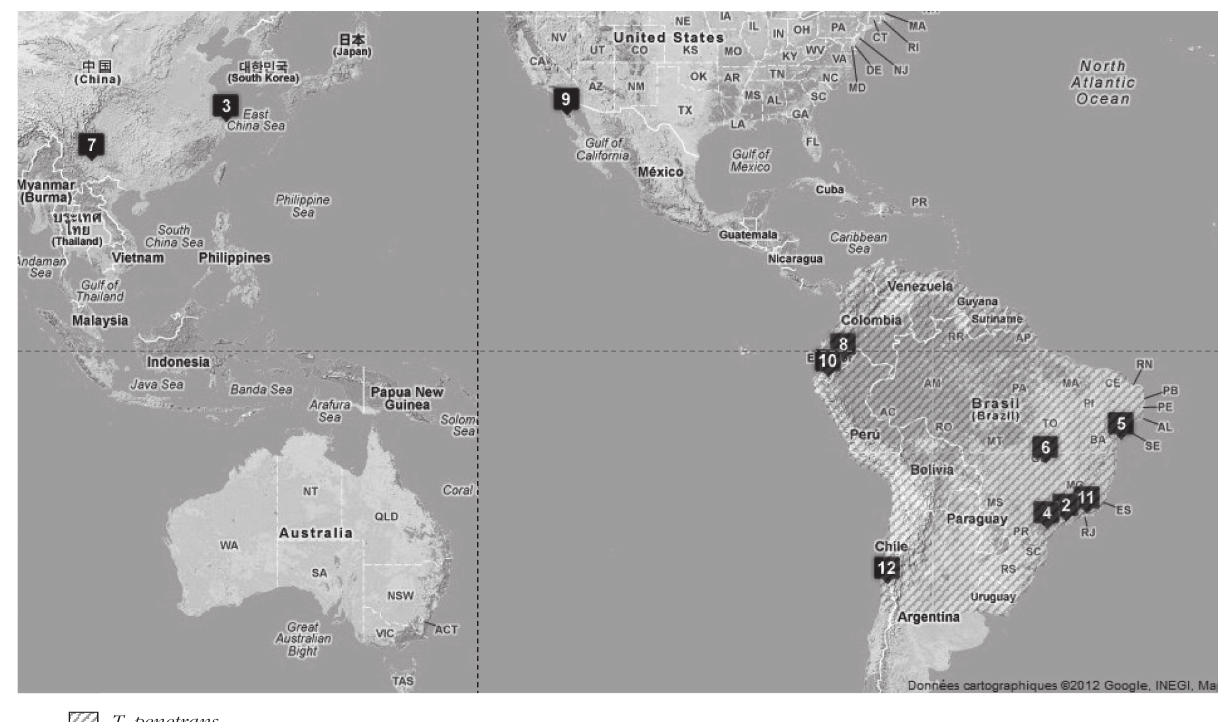
Fig. 1. – Carte de la répartition des 12 espèces décrites dans le genre Tunga Jarocki, 1838. Chaque chiffre correspond à la localité type d’une espèce. Les espèces sont classées de 2 à 12 en fonction de leur ordre chronologique de description. Le numéro 1, qui revient à T. penetrans , ne peut être valablement précisé. La zone en grisé correspond à l’aire que nous supposons primitive, mais le Brésil est le pays désigné par